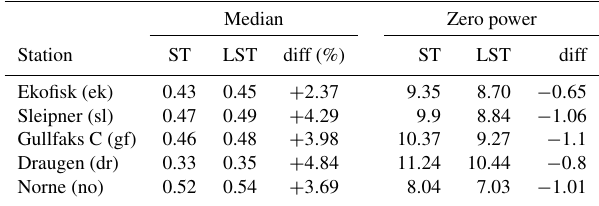
Table 4. How much the median wind power and the risk of no pro- duction changes when a linear storm control is introduced in the power conversion function (see Eq. 3). The storm control is a linear reduction from the old cutout limit (25ms − 1 ) to a new and higher cutout limit (30ms − 1 ). ST and LST correspond to “storm control” and “linear storm control”, respectively. The median “diff” is the change in percentage, while the zero-power “diff” is the difference in percentage points when introducing linear storm control.